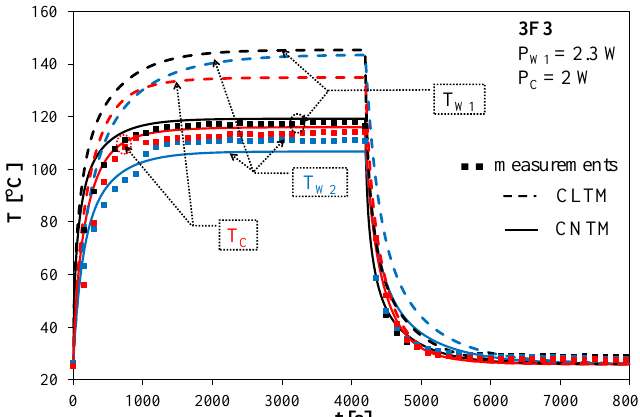
Figure 11. Measured and calculated temperature waveforms of the primary winding T W1 , the secondary winding T W2 and the core T C with simultaneous power dissipation in the windings: ( a ) P W1 = 0.88 W and P W2 = 1.05 W; ( b ) P W1 = 2.4W and P W2 = 2.7 W.